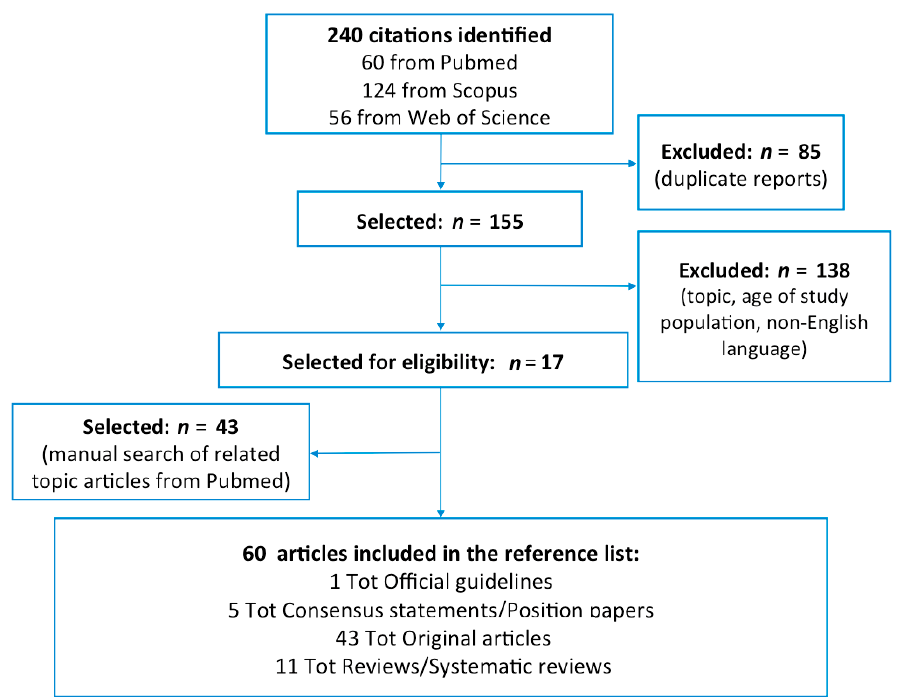
Figure 1. Flow-chart showing selection process of the articles.